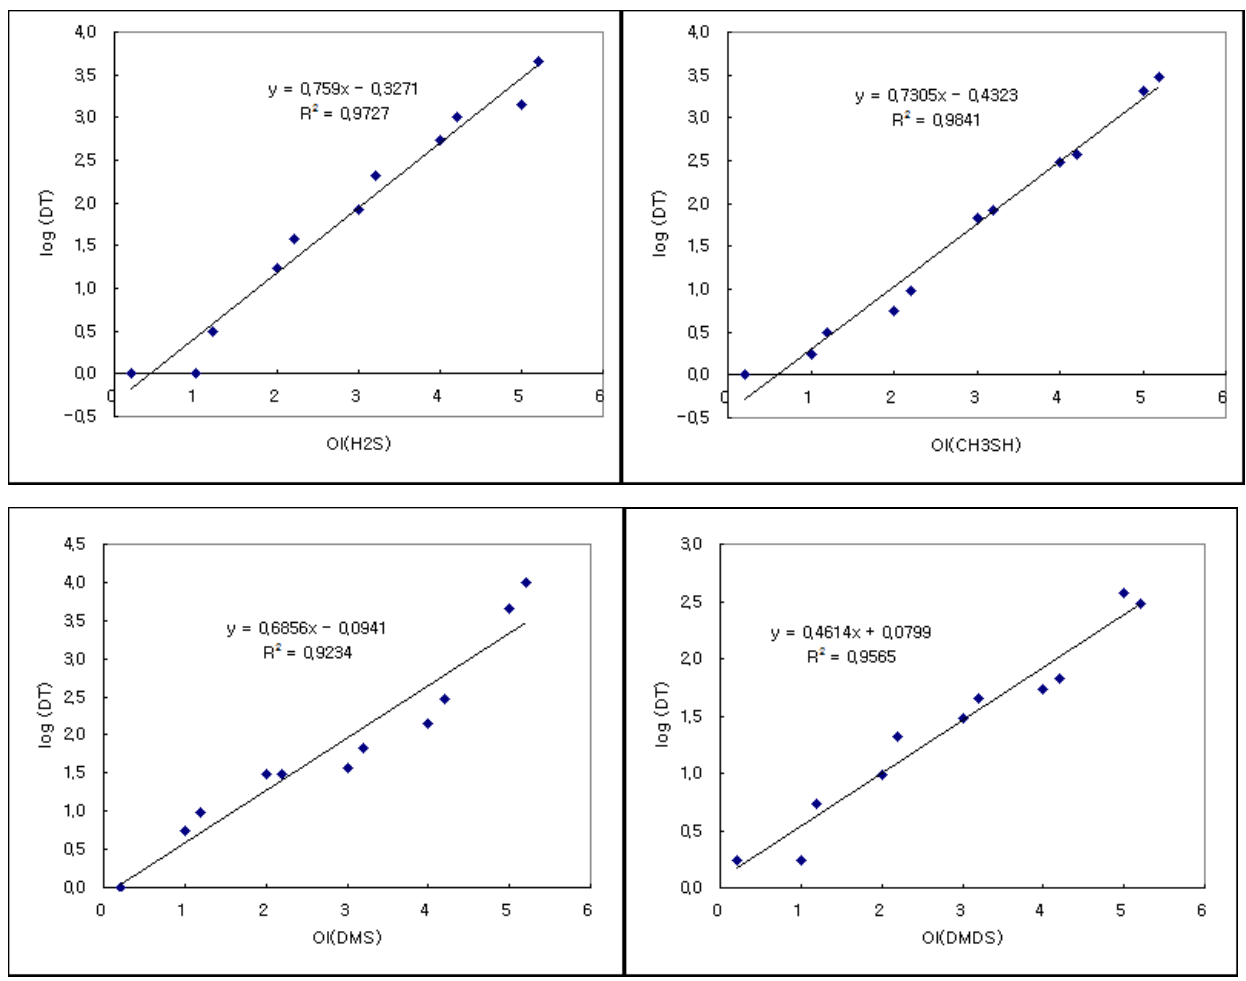
Figure 2. Relationship between odor intensity [by equations in Table 2(A) and the measured D/T ratio of 4 reduced sulfur compounds